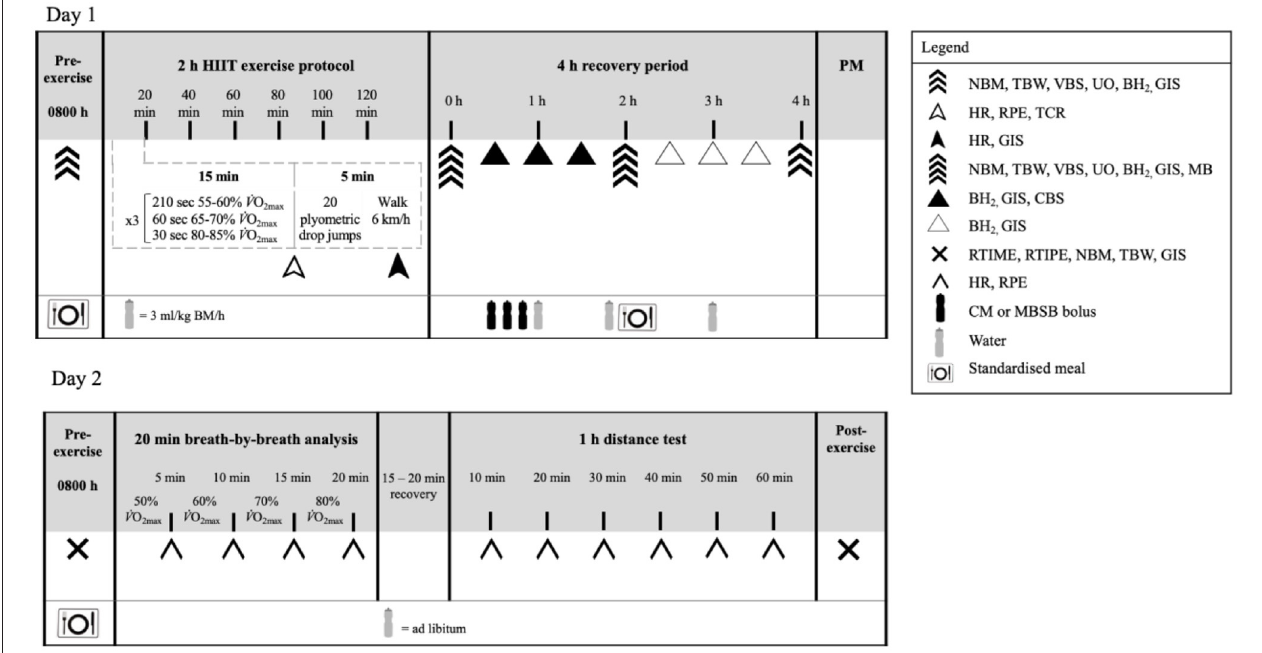
FIGURE 1 | Schematic illustration of the experimental design. NBM, nude body mass; TBW, total body water; VBS, venous blood sampling; UO, urine output and osmolality; BH 2 , breath hydrogen; GIS, gastrointestinal symptoms; Tre, rectal temperature; HR, heart rate; TCR, thermal comfort rating; RPE, rating of perceived exertion; MB, muscle biopsy; CBS, capillary blood sampling; RTIME, readiness to invest mental effort; RTIPE, readiness to invest physical effort; RER,